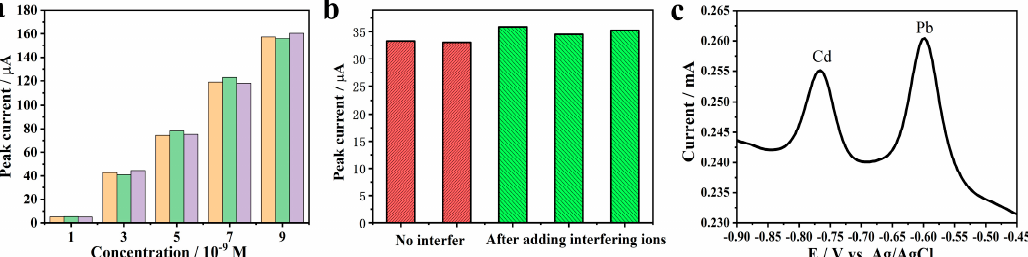
Figure 4. ( a ) The repeatability of Bi@PG for repetitive measurements via SWASV; ( b ) Effect of interfering ions (such as Zn 2+ , Na + , K + , Ca 2+ , and Cl − ) on Cd 2+ detection; ( c ) SWASV of Bi@PG in 0.2 M (pH = 5.0) acetic acid buffer solution with 10 − 7 M Cd 2+ and Pb 2+ .